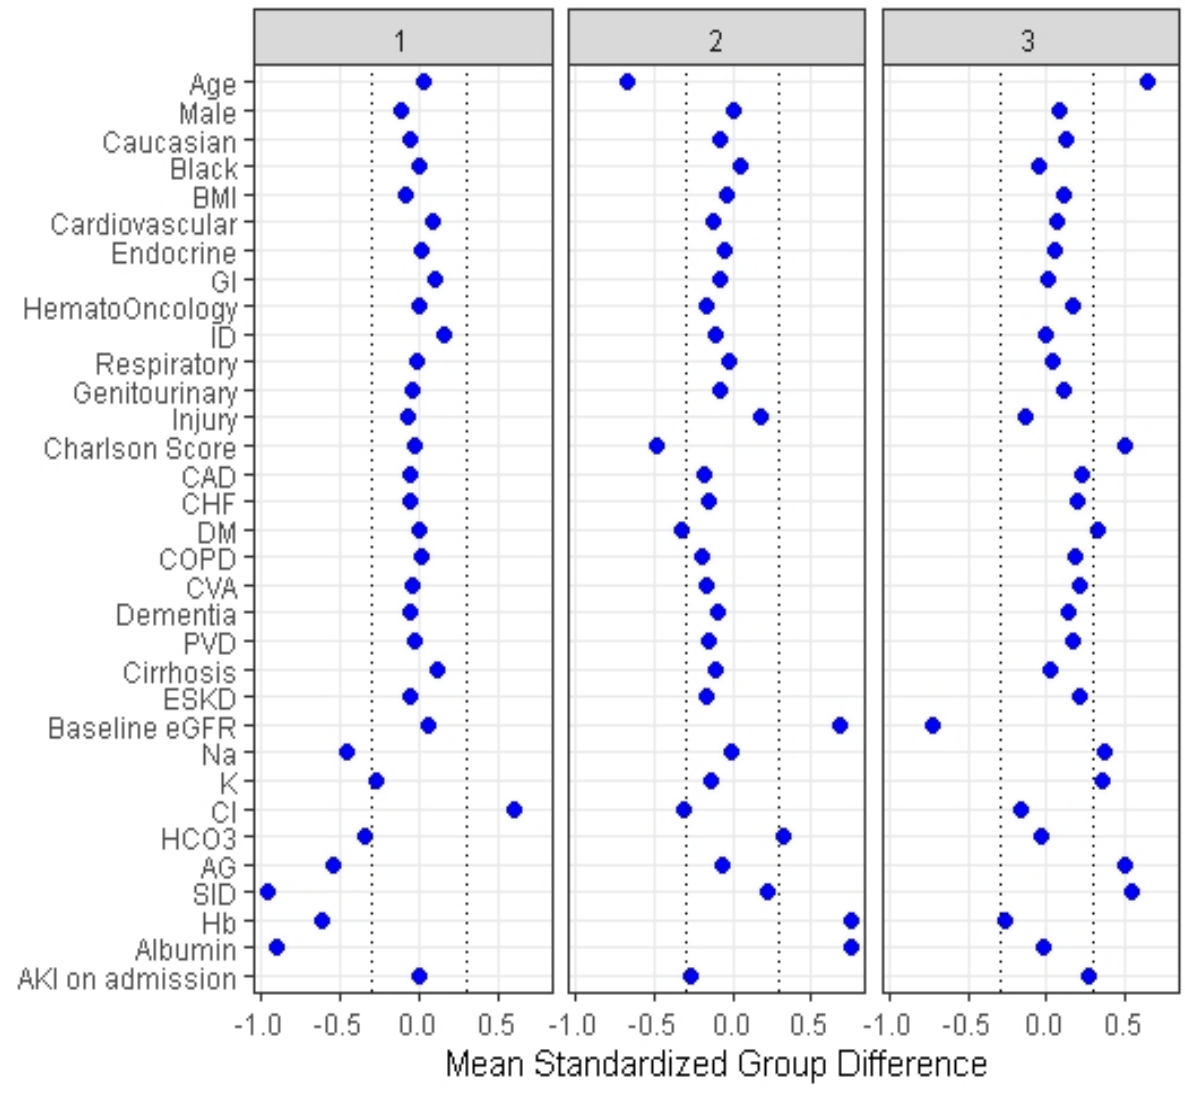
Figure 4. The standardized differences across three clusters for each of the baseline parameters. The x axis is the standardized differences value, and the y axis shows baseline parameters. The dashed vertical lines represent the standardized differences cutoffs of < − 0.3 or >0.3. Abbreviations: AKI, acute kidney injury; DM, diabetes mellitus; COPD, chronic obstructive pulmonary disease; CVA, cerebrovascular accident; PVD, peripheral vascular disease; CHF, congestive heart failure; MI, myocardial infarction; BMI, body mass index; Hb, hemoglobin; SID, strong ion difference; AG, anion gap; ESKD, end stage kidney disease; HCO3, bicarbonate; Cl, chloride; K, potassium; Na, sodium; GFR, glomerular filtration rate; RS, respiratory system; ID, infectious disease; GI, gastrointestinal.